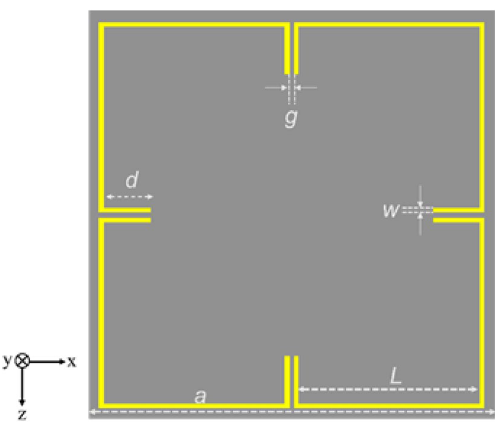
Figure 1. Geometry of the proposed metamaterial unit cell.